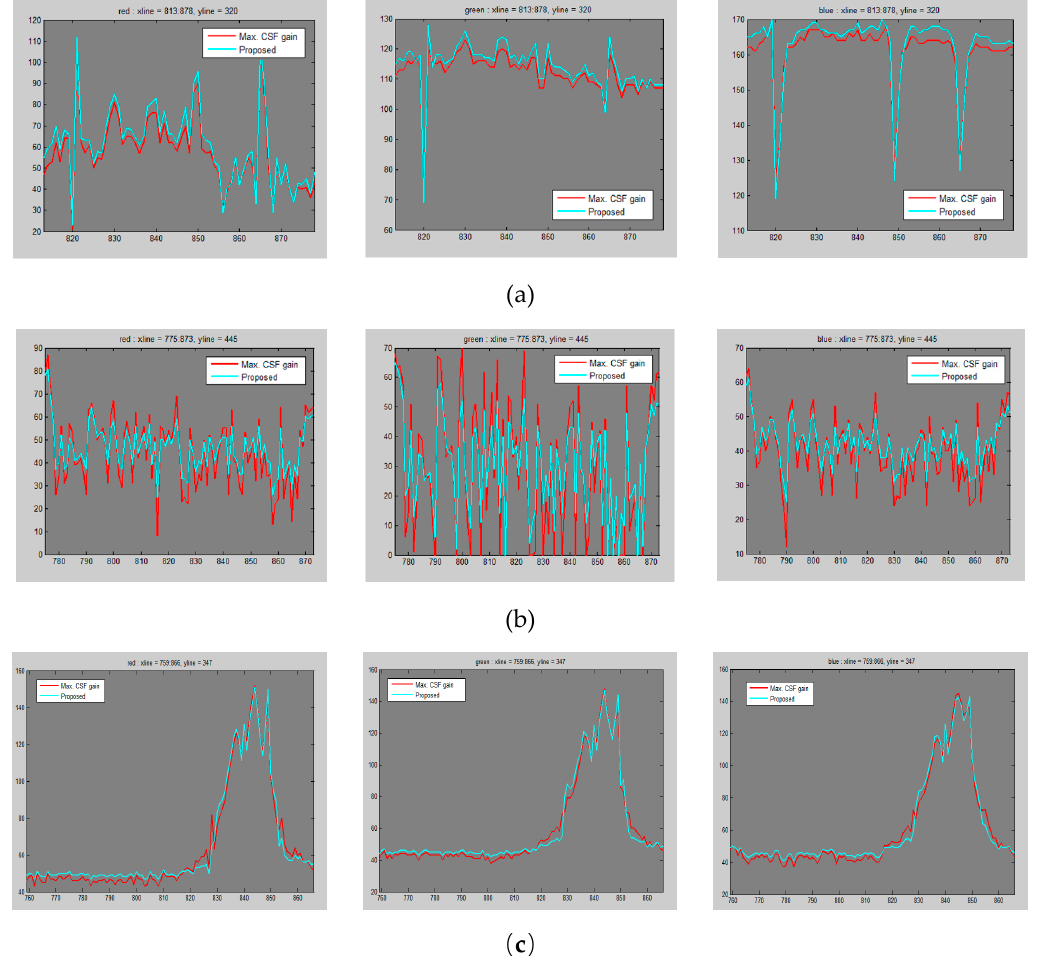
Figure 7. Comparison of the RGB channel’s noise for the scan line positions of Figure 6. ( a ) bright region (monitor) in third row, ( b ) dark region (cup) in third row, and ( c ) dark region (desktop case) in fourth row.